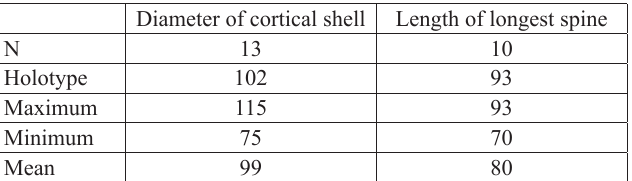
Table 1. Dimensions (in μ m) of Tozerium filzmoosense Cifer sp. nov. N, number of specimens